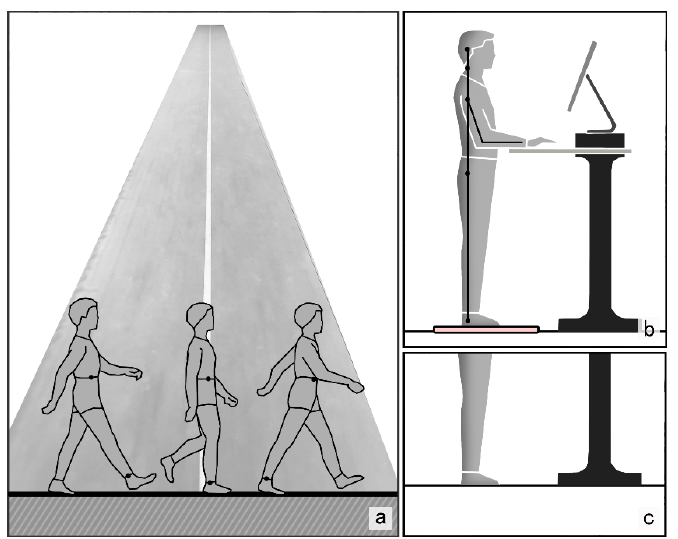
Figure 2. Schematic diagram of runway and subject standing. ( a ) Gait parameter acquisition track; ( b ) schematic diagram of the subjects standing on a mat; ( c ) schematic diagram of subjects standing on the floor.